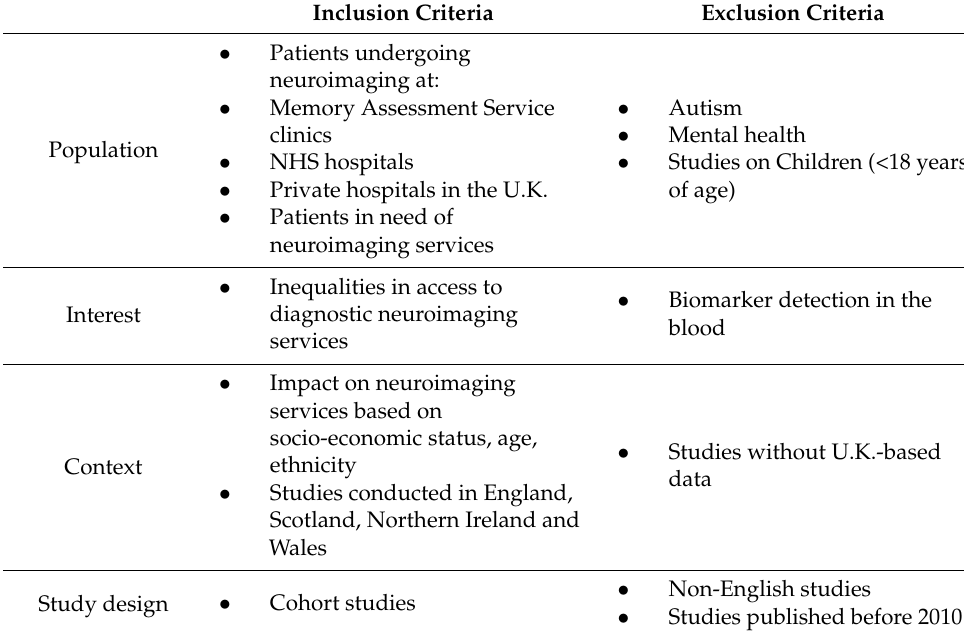
Table 3. Inclusion and exclusion